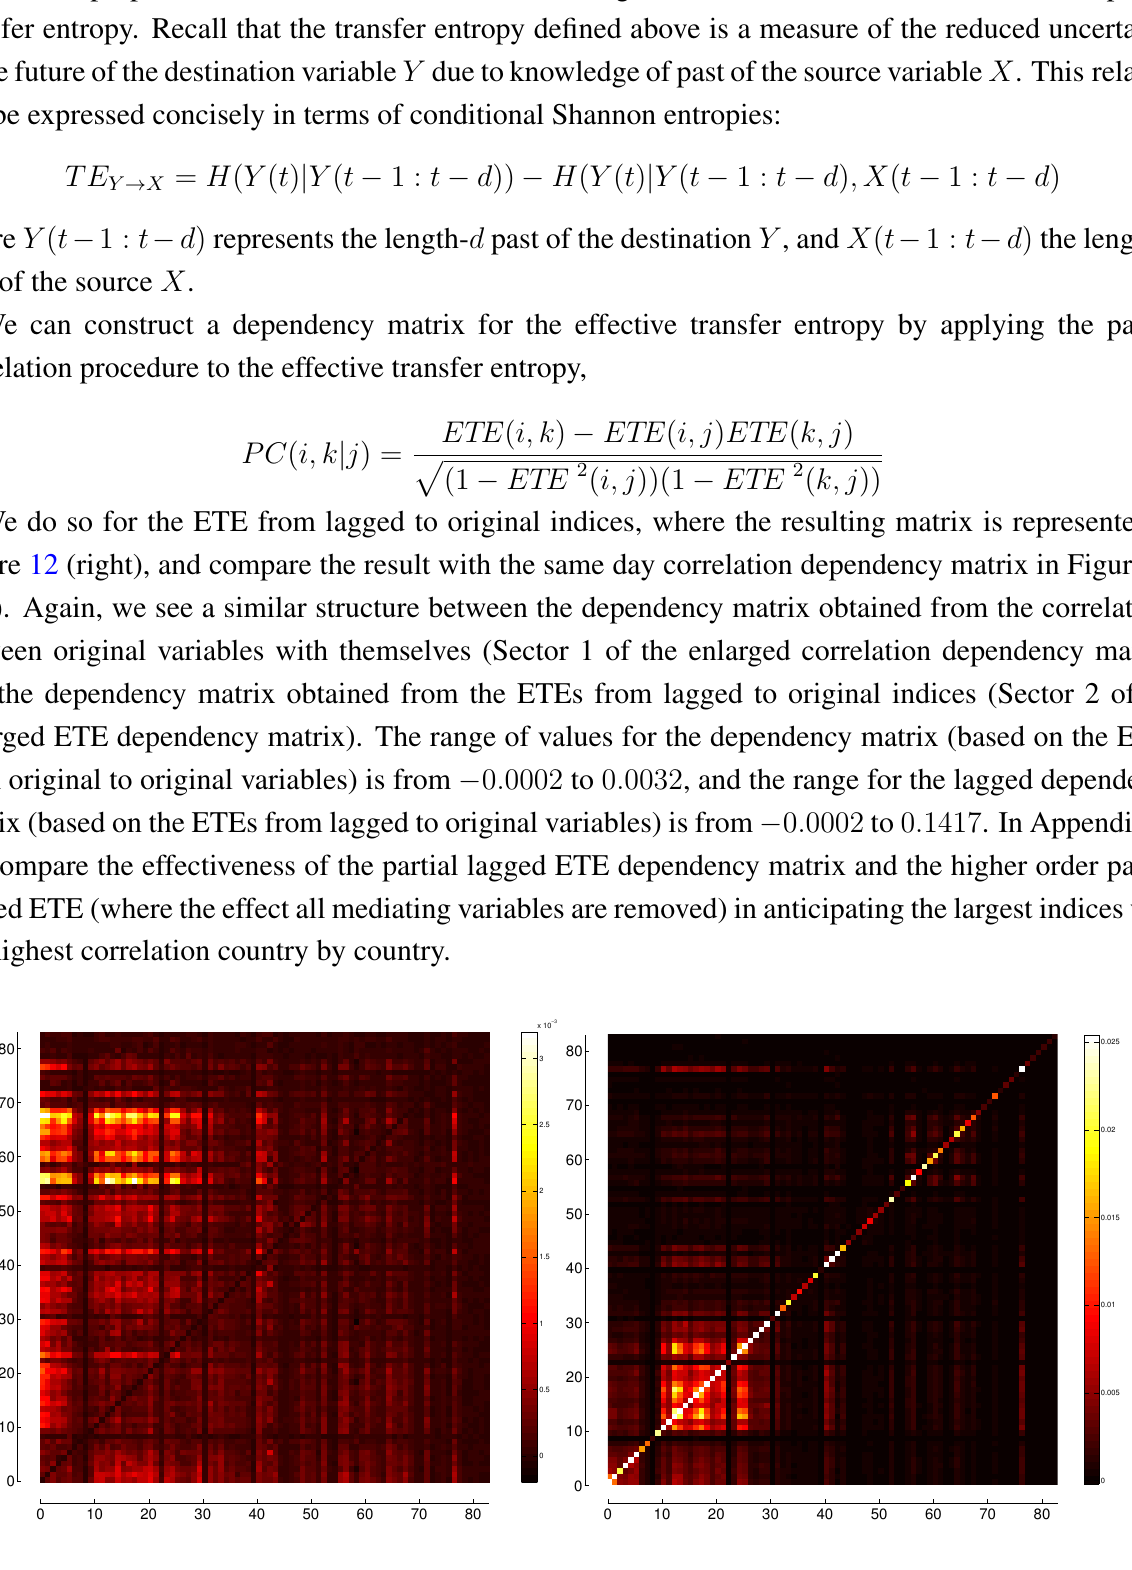
Figure 12. Heat maps of the dependency matrices built on ETE from original to original indices and from lagged to original indices,